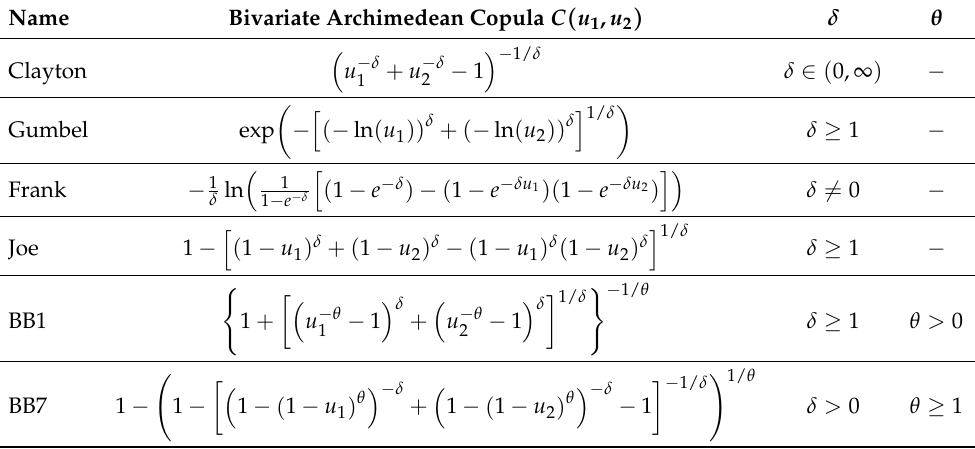
Table 1. Classes of one- and two-parametric Archimedean